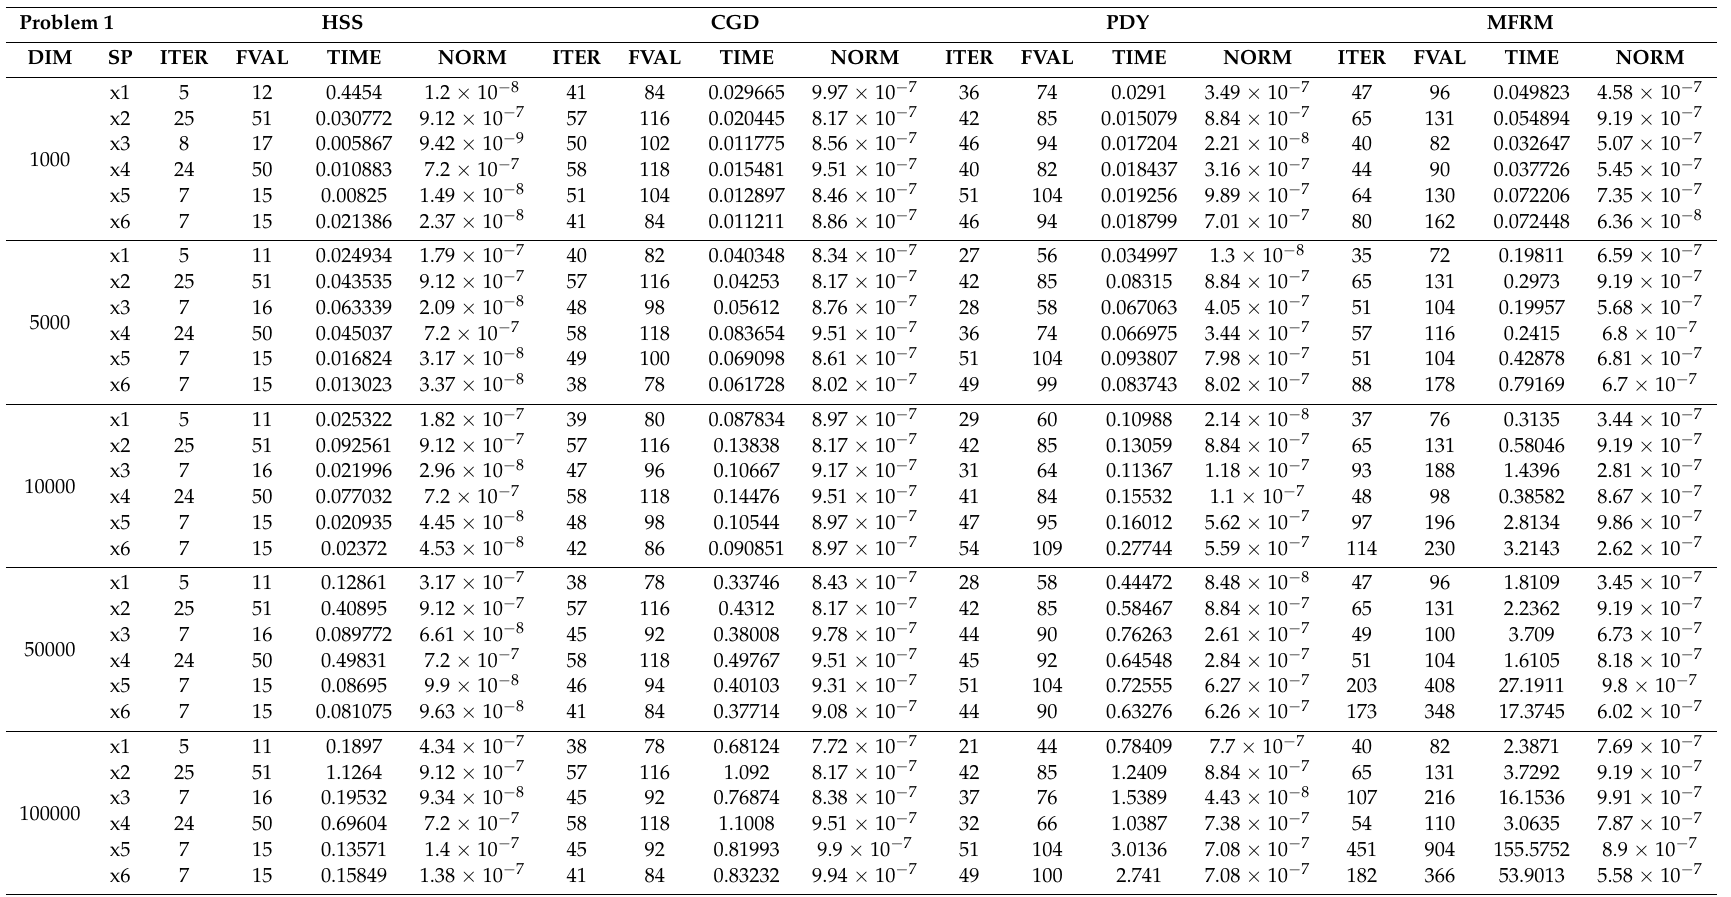
Table 1. Test results obtained by the four solvers for Problem